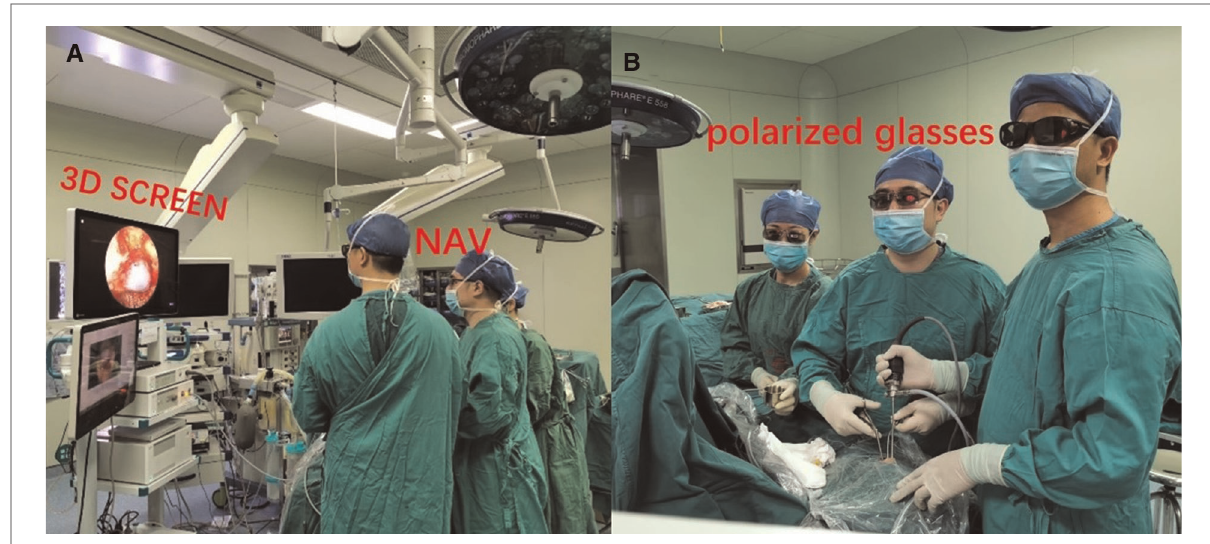
FIGURE 1 Operating room ergonomics. Position of the device in a comfortable position for surgeon, assistant, and surgical nurses (wearing polarized 3D glasses) to see the 3D video screen directly. ( A ) Placement of the 3D screen (3D SCREEN), neuronavigation (NAV). Note the distance between the surgeon and the 3D screen (at least 2 m), which is necessary for the perception of the 3D image. ( B ) Positioning of surgeon and assistant to have a direct view of the display screen. Operate using the two-person/three-hand technique.